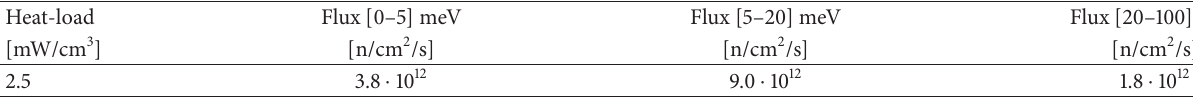
Table 1: Heat-load on cryogenic 4 He and integrated cold/intermediate/thermal flux for the ESS implementation of Golub’s UCN design discussed in the text and shown in Figure 4. The relative statistical uncertainties are ∼ 0.1%.